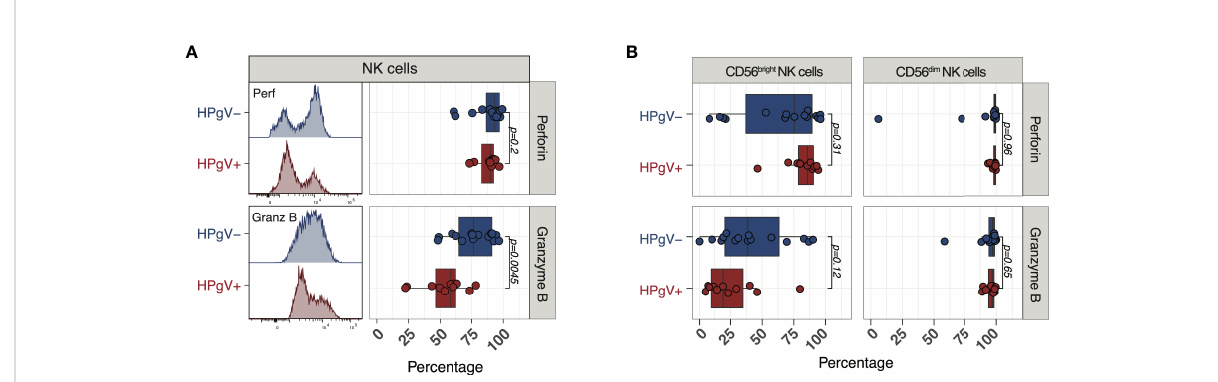
FIGURE 6 Cytotoxic molecules production in NK cells from HPgV-1-viremic and non-viremic HSCT recipients. (A) Representative FACS histograms (left panels) and summary of percentages (right panels) of expression of perforin (upper panels) and granzyme B (lower panels) in NK cells recovered at 6 months post-HSCT from HPgV-1-viremic (HPgV+; red fi lled symbols) and HPgV-1-non viremic (HPgV-; blue fi lled symbols) HSCT recipients. (B) Summary of percentages of expression of perforin and granzyme B recovered at 6 months post-HSCT from HPgV-1-viremic (HPgV+; red fi lled symbols) and HPgV-1-non viremic (HPgV-; blue fi lled symbols) in CD56bright (left panels) and CD56dim (right panels) NK cells from HSCT recipients. Results in the two patient groups were compared using a nonparametric Mann-Whitney U